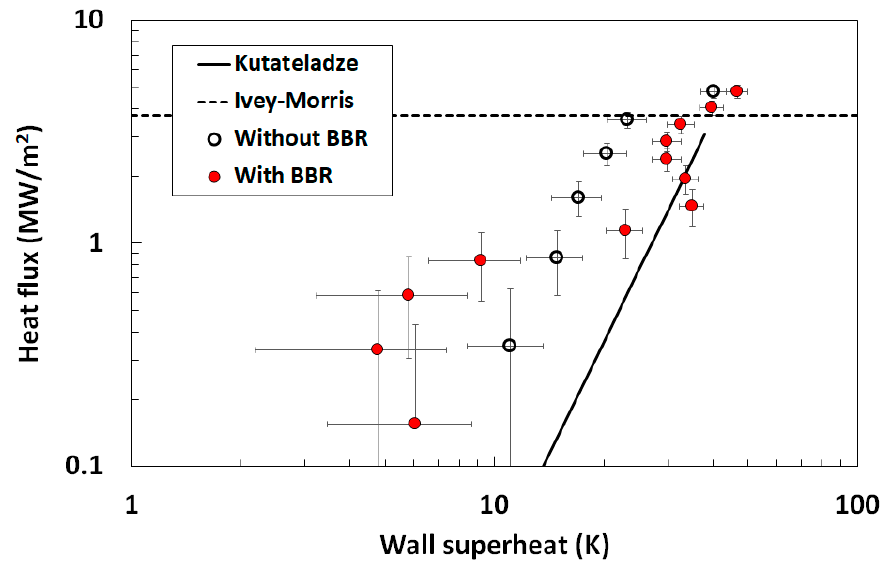
Figure 3. Atmospheric-pressure boiling curves with and without the BBR. The degree of liquid subcooling was 50 K.